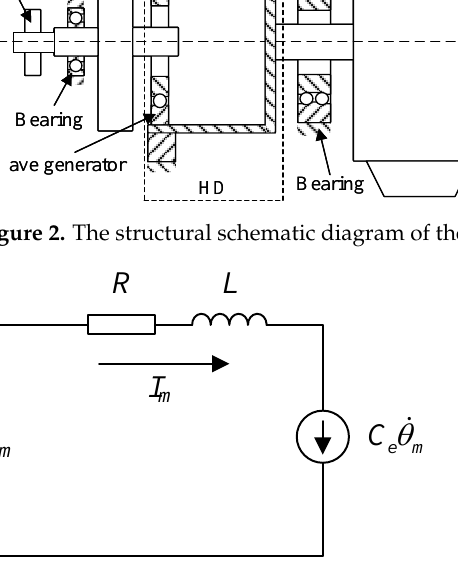
Figure 3. The equivalent electrical circuit of the DC